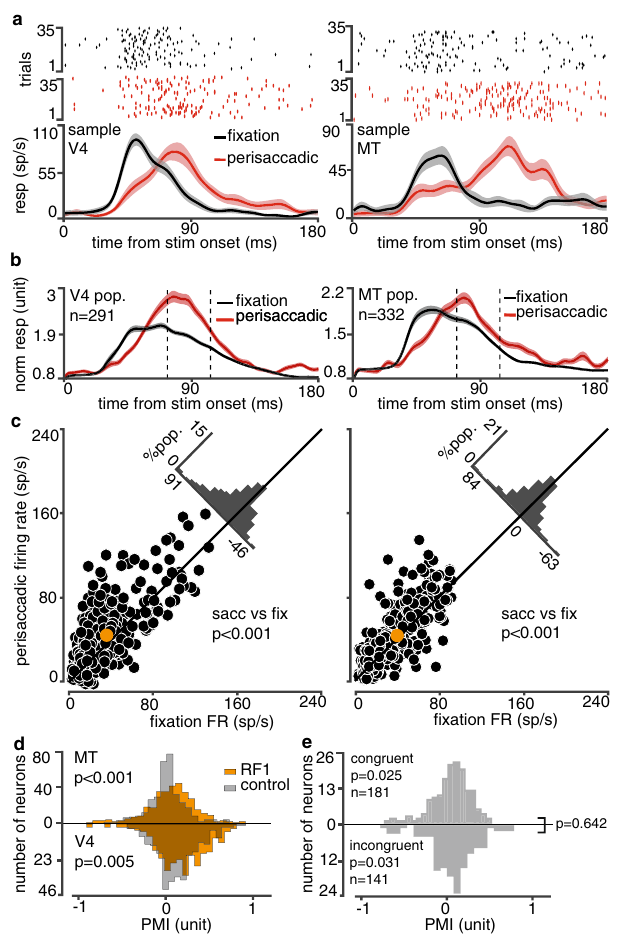
Fig. 4 Late modulation of perisaccadic RF1 response. a , b Responses (mean ± SEM over trials of a single neuron, or across neurons) of sample neurons ( a ) and the neural population ( b ) to perisaccadic versus fi xation RF1 probes in area V4 (left) and MT (right). Dashed lines indicate the late response window used in ( c – e ). c The average late response of V4 (left) and MT (right) neurons to perisaccadic versus fi xation RF1 probes (V4, p = 9.10 × 10 − 10 ; MT, p = 3.31 × 10 − 5 ). Orange dots indicate center of mass. d PMI values for RF1 (orange) and control probes (gray), for the MT (top; p = 1.12 × 10 − 4 ) and V4 (bottom) populations. e PMI values for saccade directions congruent (top) versus incongruent (bottom) with MT neurons ’ preferred motion direction. pop., population. ‘ n ’ indicates the total number of neurons with congruent or incongruent saccade directions (including data from single-direction and two-direction recording sessions). P -values above and below y = 0 in ( c – e ) are for two-sided Wilcoxon signed-rank tests (median of distribution vs. 0), and for a two-sided Wilcoxon ranked- sum test of congruent versus incongruent on the right in ( e ). Source data are provided as a Source Data fi